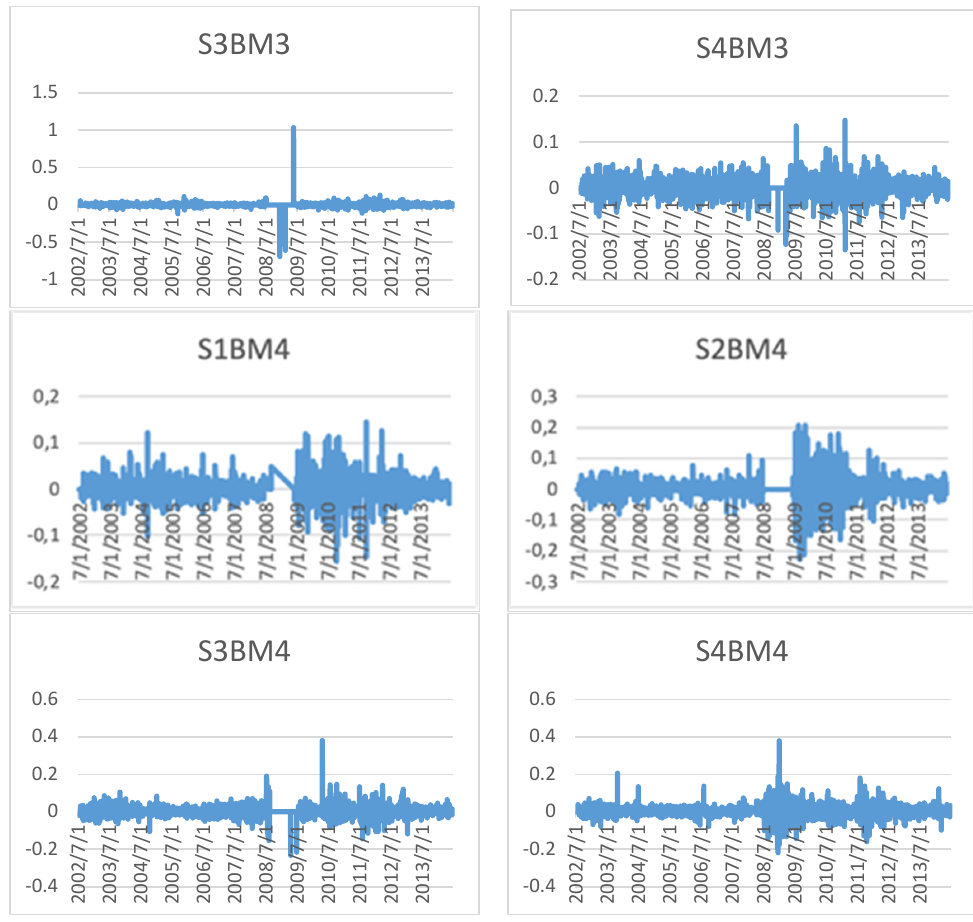
Figure A7. Daily Returns of Portfolios of Size (S) and Value (BM (BM1 Is the Low Book to Market Value Quartile portfolio Figure A7. and BM4 is the High Book to Market Value Quartile Portfolio)) Factor Data.